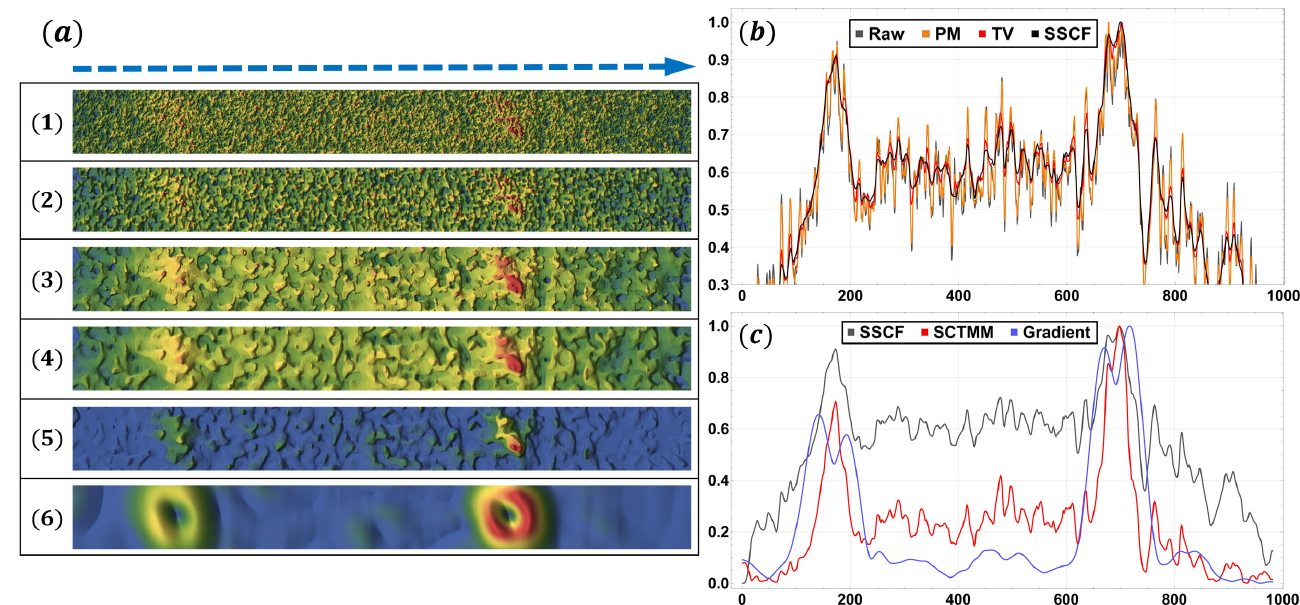
Figure 8. The effect of filtering stages on bubble signal versus noise and background: ( a ) pseudo-3D shaded relief plots of strips taken from Figure 6a–f (sub-figures 1–6, respectively) containing bubbles and background in between; ( b ) mean luminance profiles over image strips (1–4) in the direction indicated by a blue dashed arrow in ( a ) for pre-processed, PM-, TV- and SSCF-filtered images; ( c ) mean luminance profiles for SSCF-, SCTMM- and gradient-filtered strips (4–6). Note that all luminance profiles in ( b , c ) have been normalized for direct